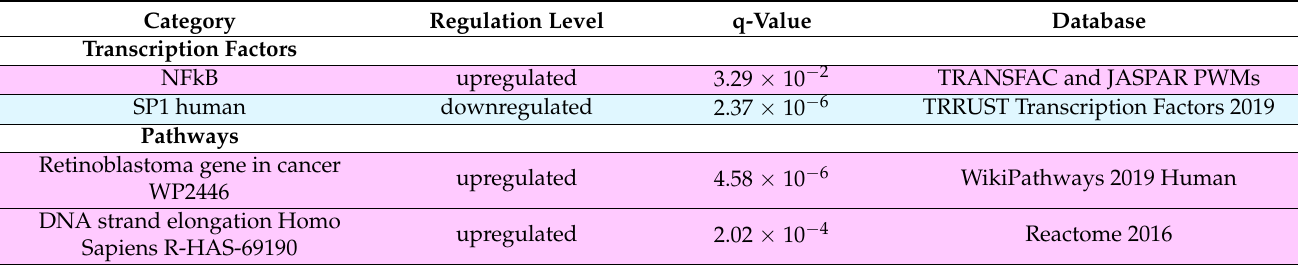
Table 2. Representative enriched pathways, ontologies, and transcription factors filtered by A. Enrichr and B. PANTHER (from November